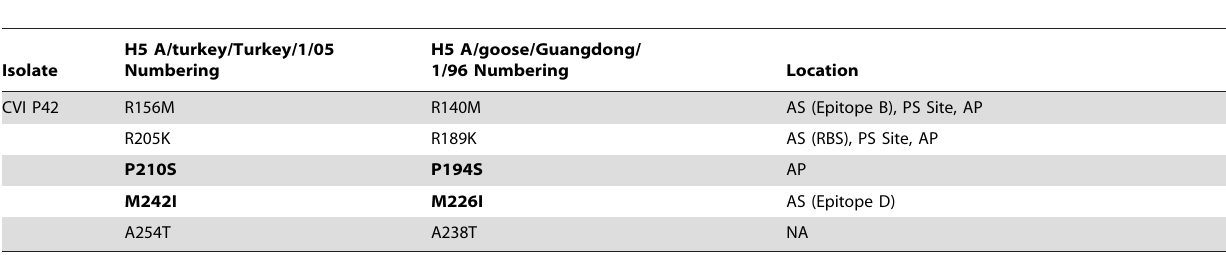
Table 2. Summary of amino acid mutations found in the HA protein of CVI P42, and their locations in respect to antigenically- relevant